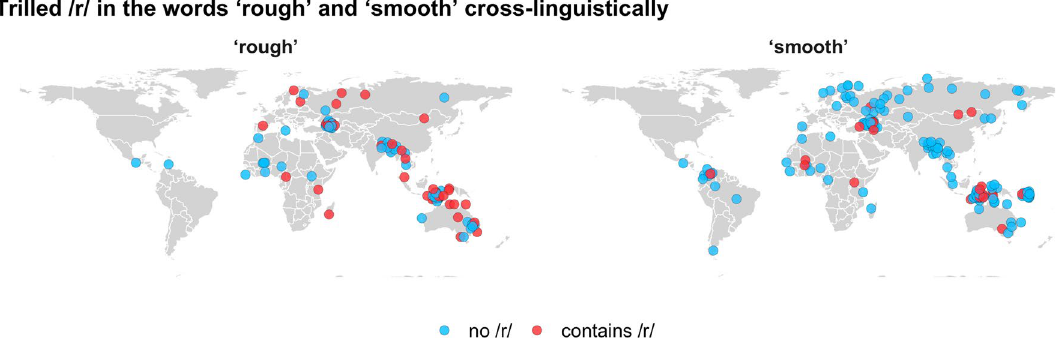
Figure 2. Words for the concepts ‘rough’ and ‘smooth’ in 179 spoken languages that have a trilled /r/ in their phoneme inventory, showing a much higher percentage of /r/ in rough words than smooth